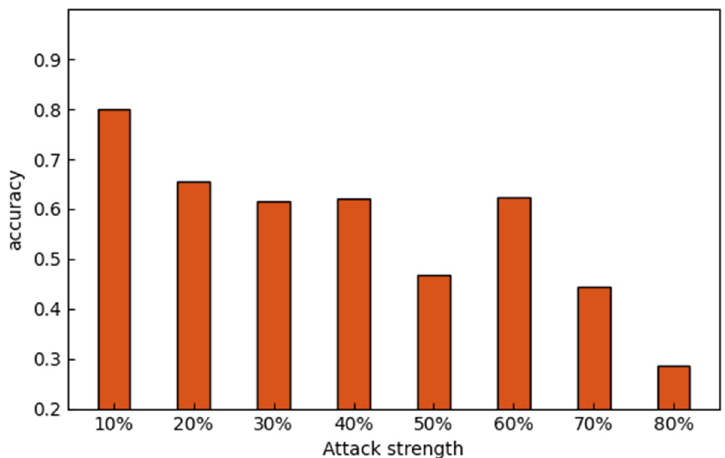
Figure 10. Influence of data poisoning attack strength on accuracy.